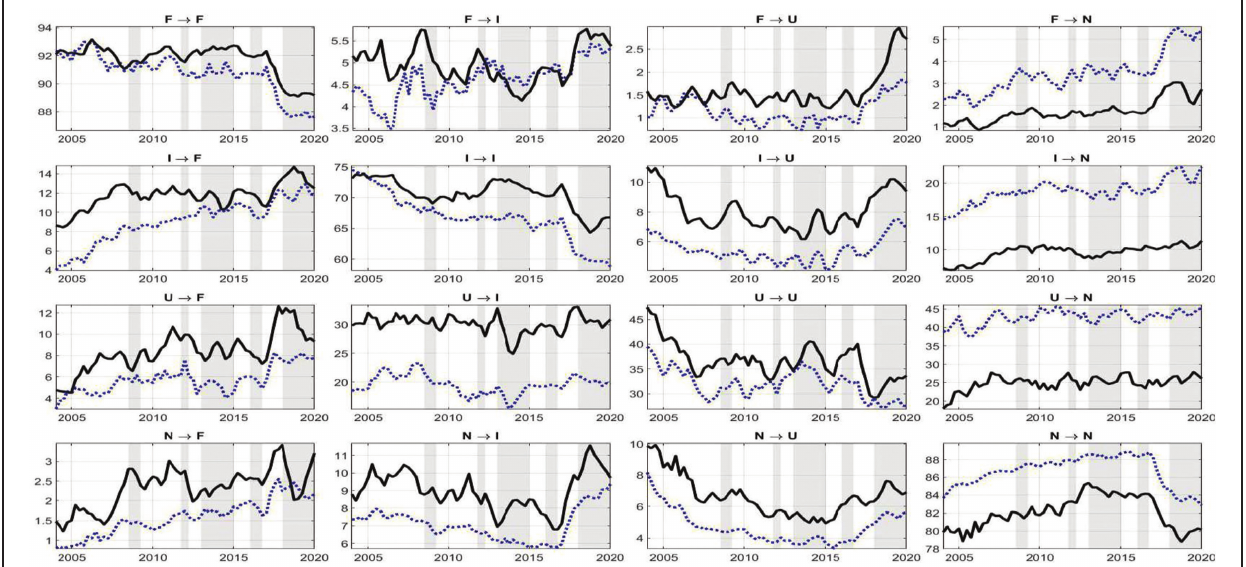
Source : Argentine Household Survey. Panels A, B, C, and D: stocks as% of the working-age population. Shaded areas denote recession periods based on the Argentine Central Bank (BCRA) calculations.